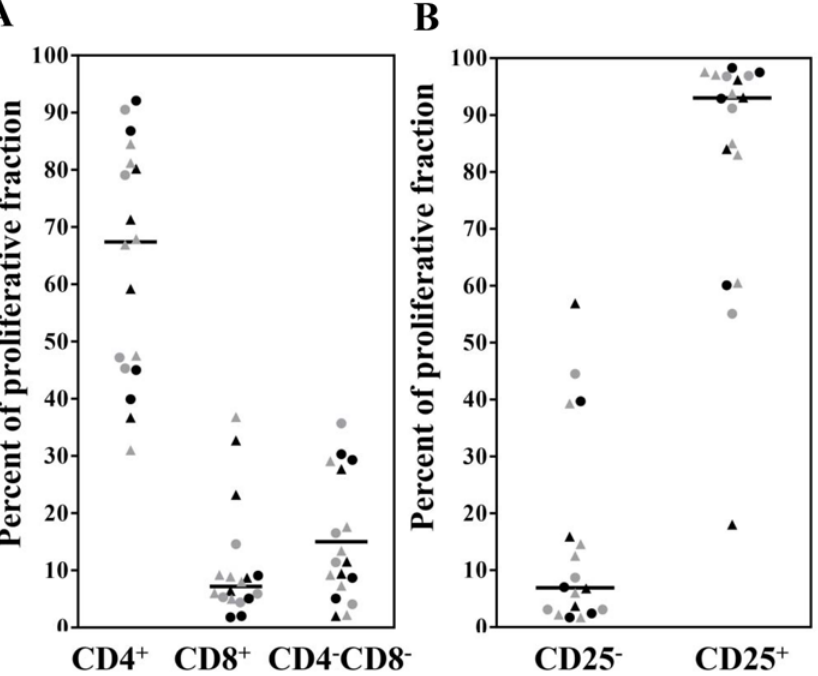
Fig 3. Identification of responding populations by CFDA-SE labeling and flow cytometry analysis. Identification of proliferating lymphocytes based on expression of ( A ) CD4 and CD8 or ( B ) CD25. Circles represent SSG subjects and triangles represent TM subjects. Black and grey are for PRE and POST respectively. Bars represent medians.